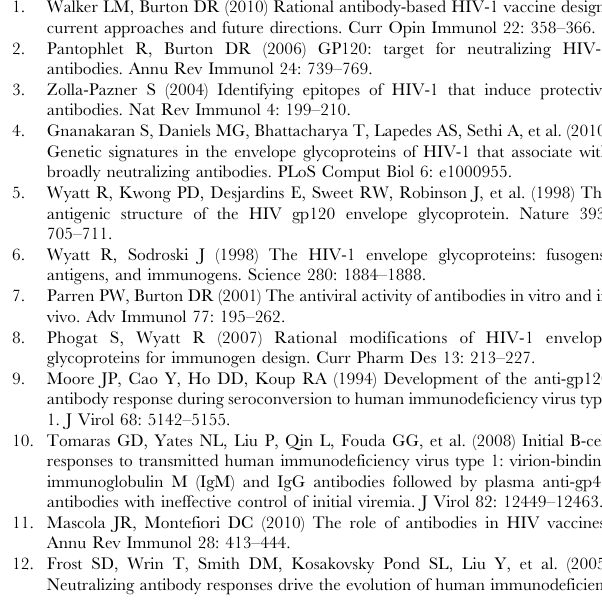
Figure S1 Effect of Y681H substitution on degree of inhibition of Env-pseudotyped viruses by T20. The percent reduction in infectivity of each virus indicated on Y-axis at various dilutions of T20 indicated on X-axis in TZM-bl cells were assessed by measuring the reduction in relative luminescence units (RLU) in a luminometer. Experiments were done in duplicates and repeated at least three times. Note that Envs expressing H681 showed increased inhibition by T20 than the Y681 version of respective Env (P= 0.04).